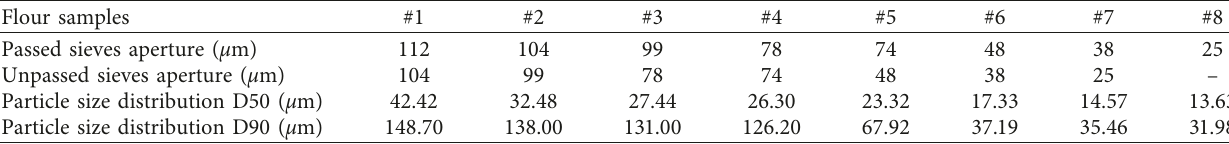
Table 2: Flour samples and their passed and unpassed sieves.